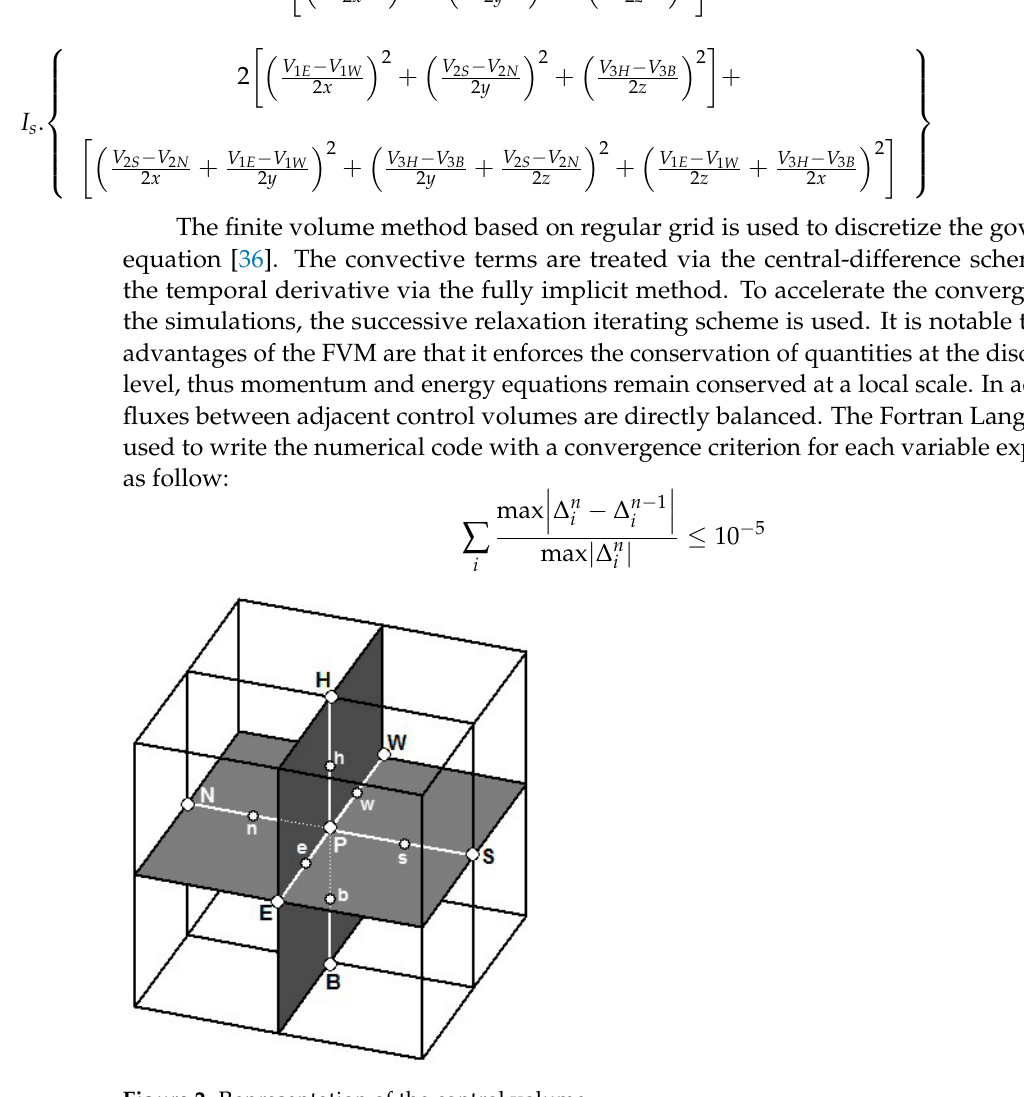
Figure 2. Representation of the control volume.